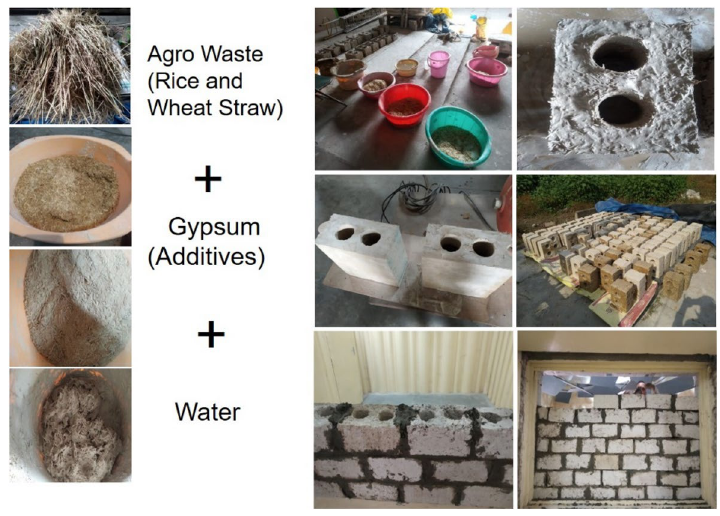
Figure 2. Process, casting, sun drying and wall construction of agro-waste gypsum blocks.